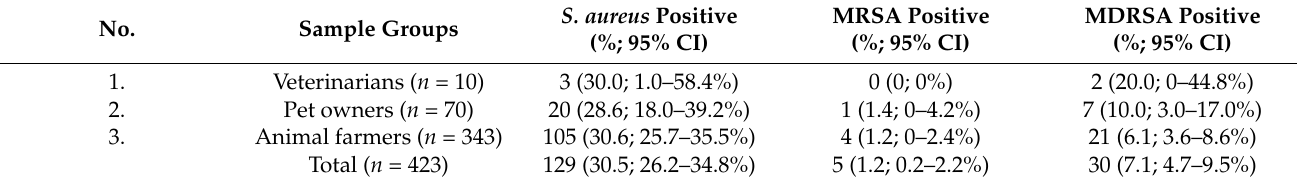
Table 1. The carriage rates of S. aureus , MRSA and MDRSA among animal handlers ( n = 423) according to sample groups (veterinarians, pet owners and animal